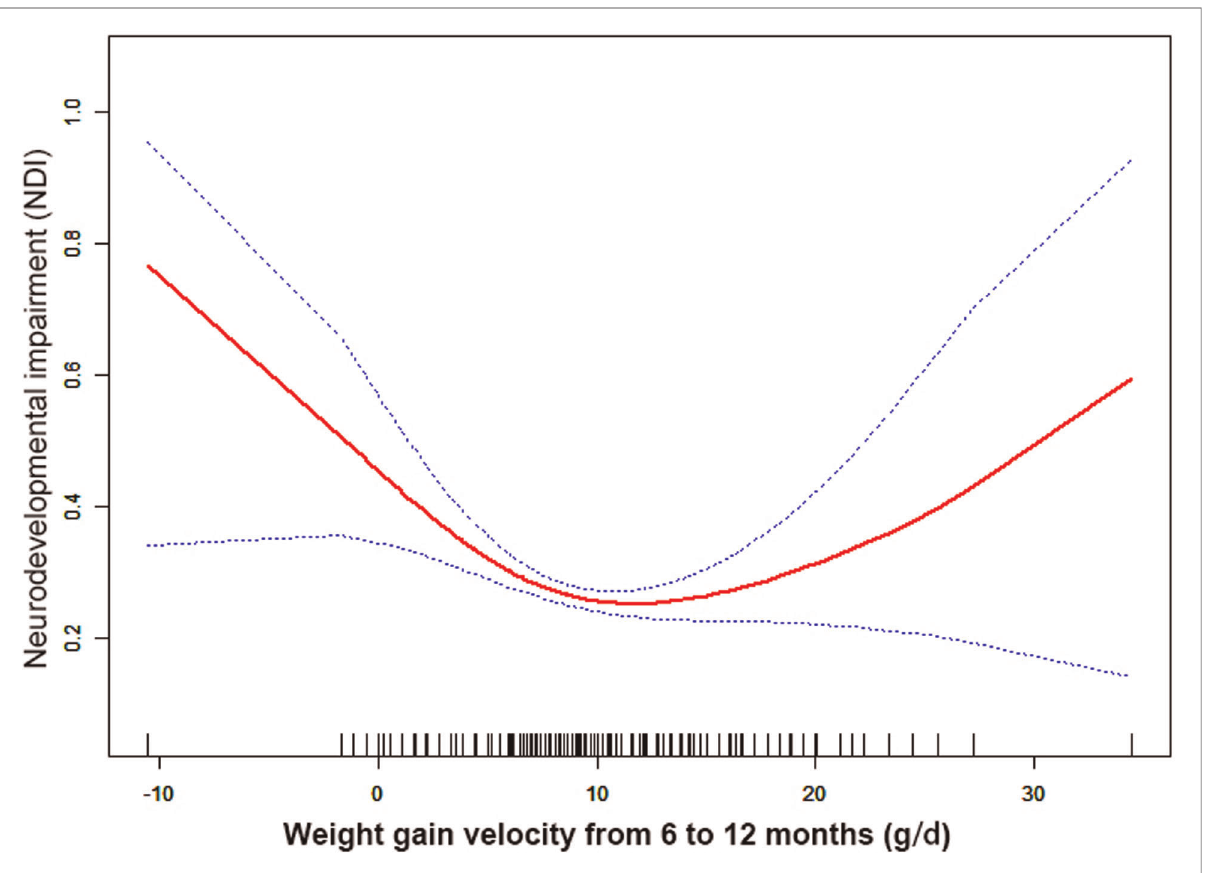
FIGURE 2 Nonlinearity of weight gain velocity from 6 to 12 months CA on neurodevelopmental